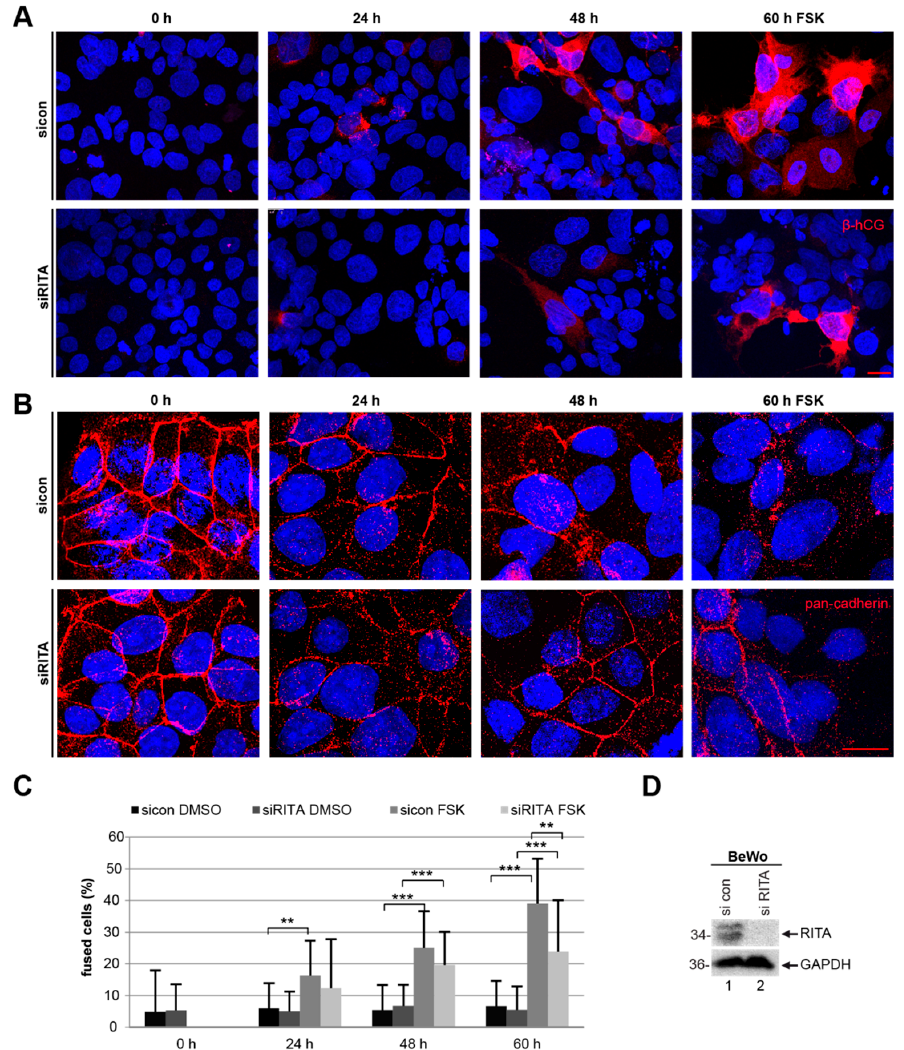
Figure 6 . Suppression of RITA impairs the fusion rate of BeWo cells. BeWo cells were treated with control siRNA (sicon) or siRNA targeting RITA (siRITA) for 24 h and additionally with forskolin (FSK) or DMSO for indicated time periods. ( A ) Treated BeWo cells were fixated and stained for the fusion marker β -hCG (red) and DNA (DAPI, blue). Examples are shown. Scale: 25 μ m. ( B ) The treated BeWo cells were stained for pan-cadherin (red) and DNA (DAPI, blue). Representative images are shown. Scale: 25 μ m. ( C ) For microscopic evaluation and quantification of fused cells, the pan-cadherin (red) and DNA (DAPI, blue) staining were used. The results are displayed in percentages at indicated time periods. The results are shown as mean ± standard deviation (SD). Student’s t -test, ** p < 0.01, *** p < 0.001. ( D ) Western blot analysis using antibodies against RITA and GAPDH. GAPDH served as loading control.